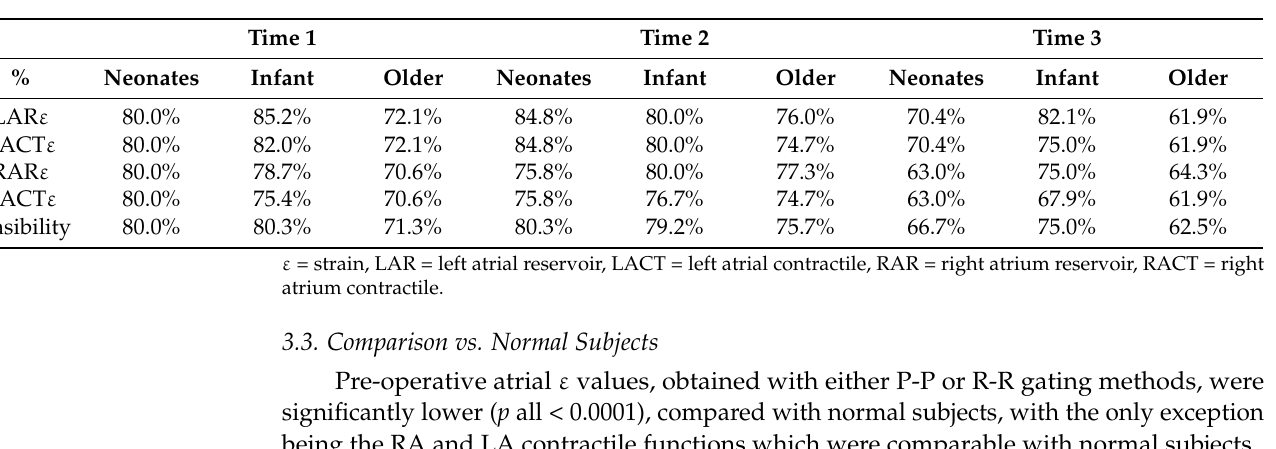
Table 2. Feasibility at different post-operative times and in different age groups.